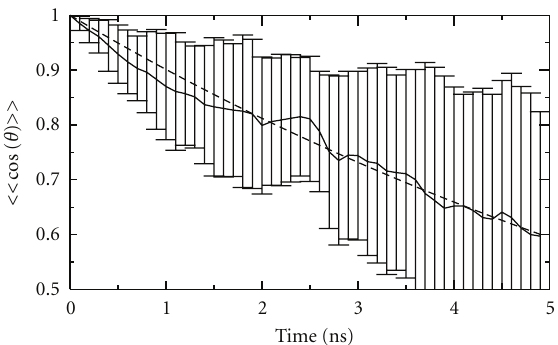
Figure 2: Average of (cid:4) cos( θ ) (cid:5) versus time with standard deviations as bars, where (cid:4) cos( θ ) (cid:5) is the average cosine of the angle between two vectors rigidly anchored on the di ff using molecule at time 0 and at time t . Averaging is performed over 27 molecules. Data are from the simulation reported in [10].